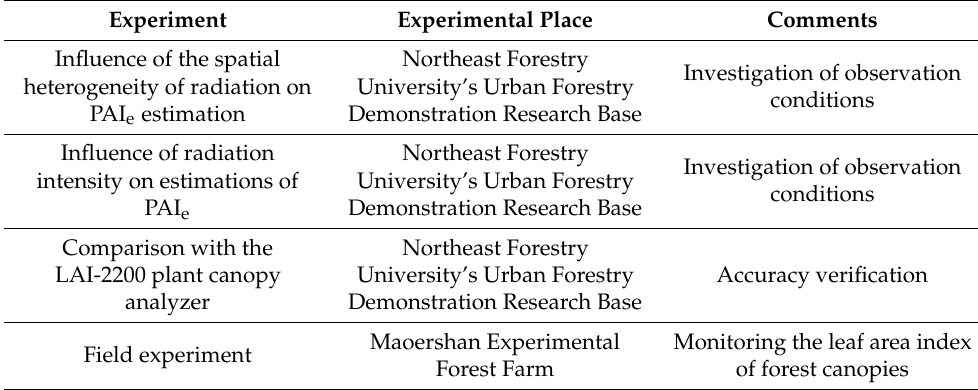
Table 2. Experiment